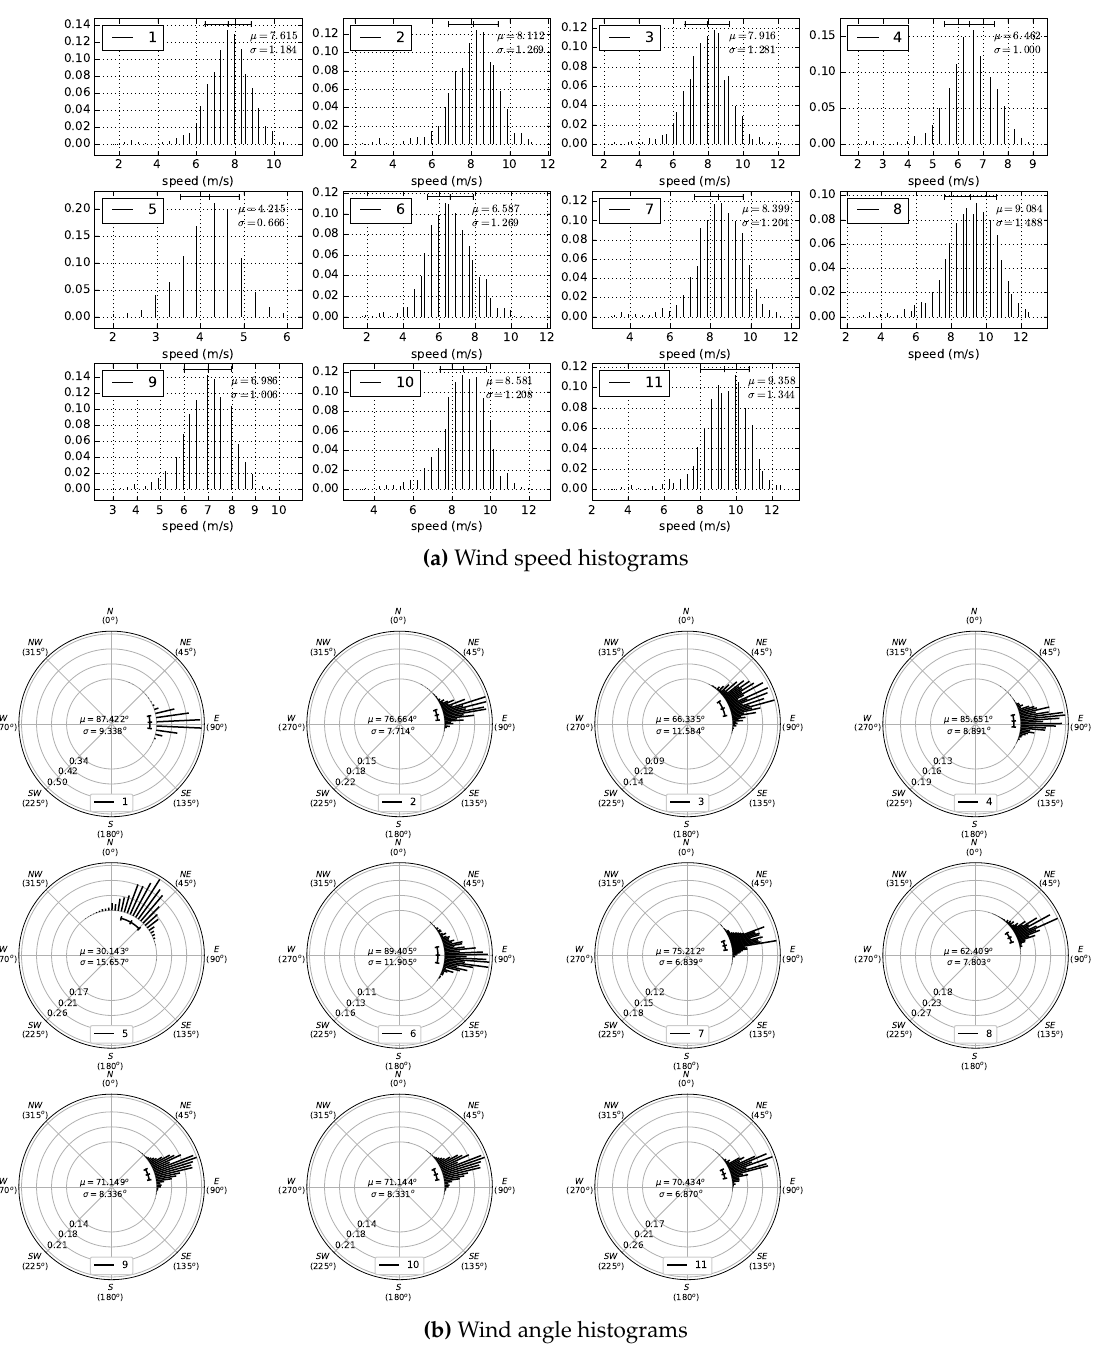
Figure 13. First data acquisition session. Time period: 10:30 a.m.–12:17 p.m. Eleven sensors were used in this experimental session. ( a ) and ( b ) show respectively the normalized histograms of wind speed and direction acquired by each sensor during the experiment. Each histogram line represents the fraction of measurements in a discrete interval or bin of speeds and angles, respectively. Bins are evenly spaced and have the same